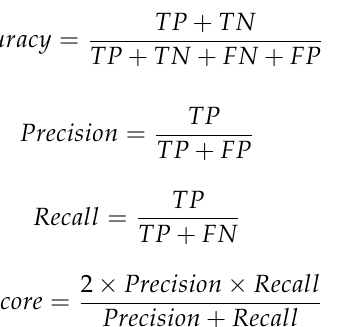
Figure 5. The distribution of the training and testing datasets in each part of experiments. The aforementioned algorithms, SVM, DT, LG, KNN, and RF, were trained and tested based on the explained sets. Moreover, the performances of each detection model were evaluated by calculating the appropriate metrics, namely the accuracy, precision, recall, and f1-score. These metrics are evaluated based on the results of the confusion matrix, which compute the true positive, false positive, true negative, and false negative rates for classes of binary classification. The evaluation metrics are computed as